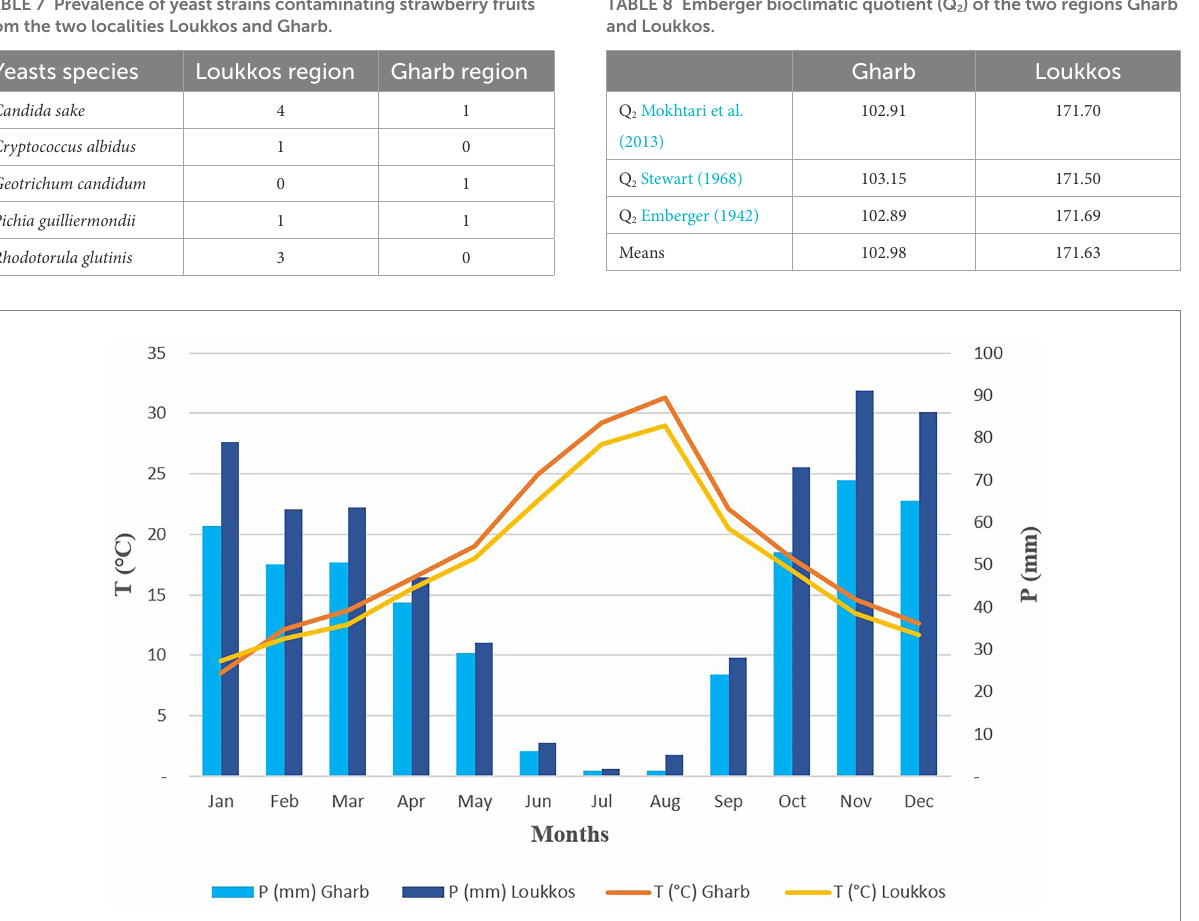
FIGURE 2 Umbrothermal diagram (temperature and precipitation) of the two regions Gharb and Loukkos.